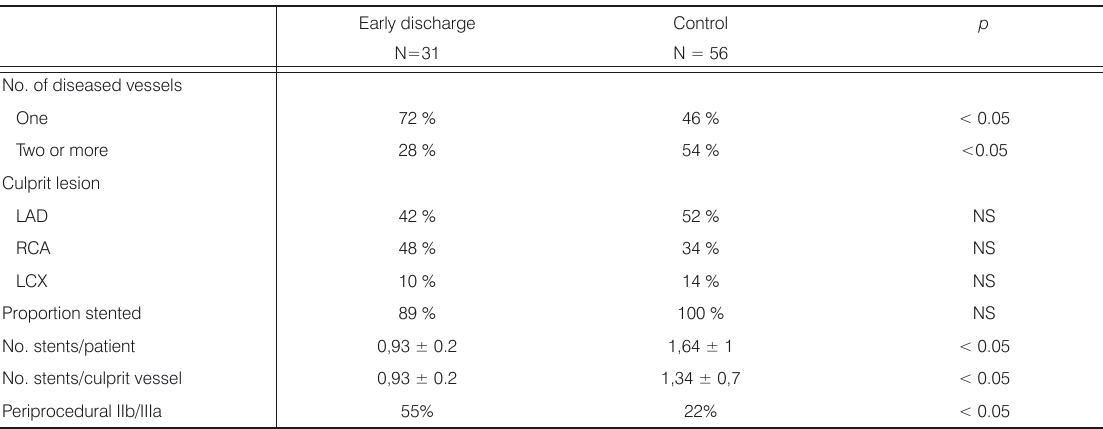
Table 2. Results of cardiac catheterisation. Results are presented as